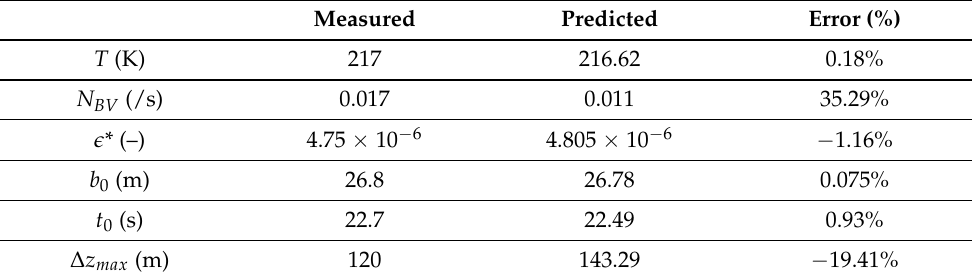
Table 1. Comparison of predicted and measured [25] data Table includes data from source and our own data in a different format; we believe that there is no copyright issue here. for an aircraft with mass M a = 47,000 kg and wing span s a = 34.1 m, flying at TAS = 224 m/s at an altitude of 320 hft.